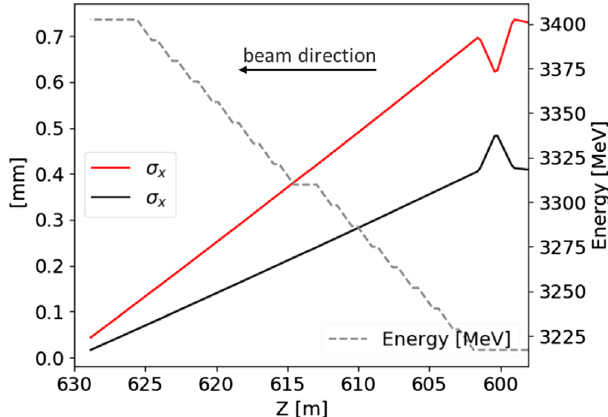
FIG. 11. Horizontal and vertical beam envelopes behavior and energy gain in L2, the last machine acceleration region dedicated to the final energy tuning.